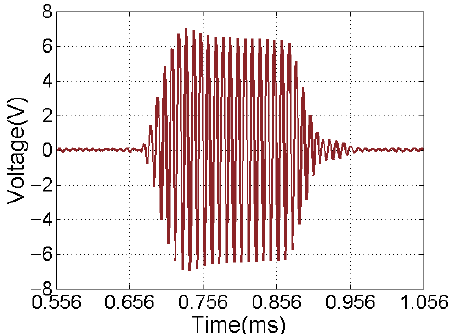
Figure 21. The output ultrasonic signal of standard hydrophone.